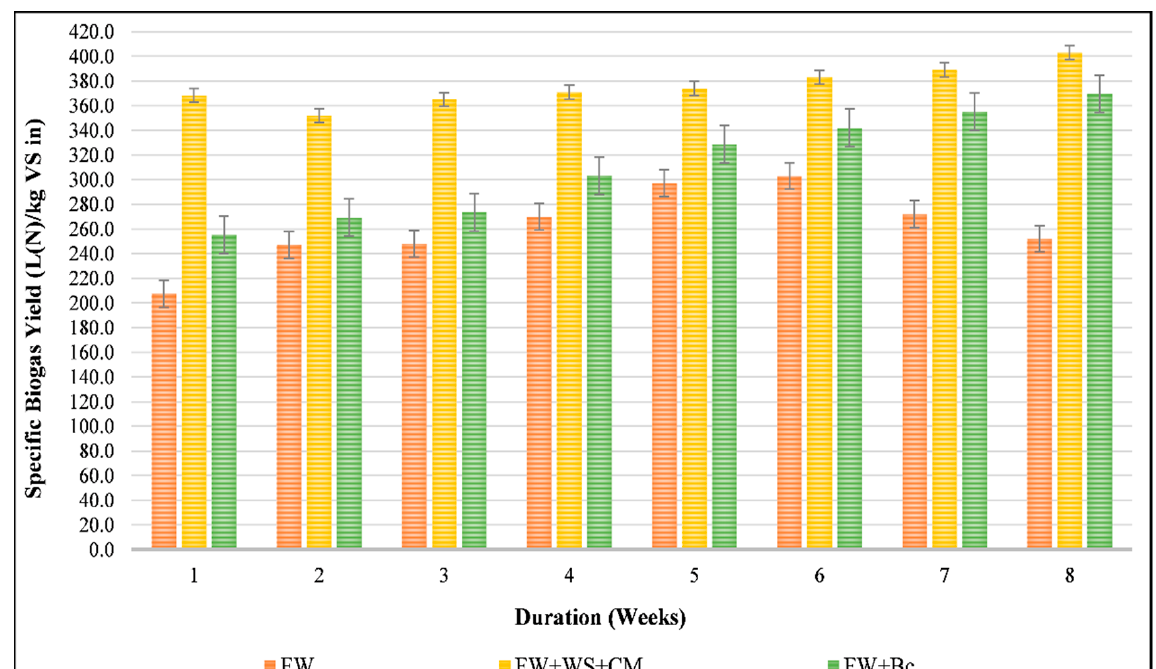
Figure 3 . Effect of mixing substrates on specific biogas yield during the start-up conditions.